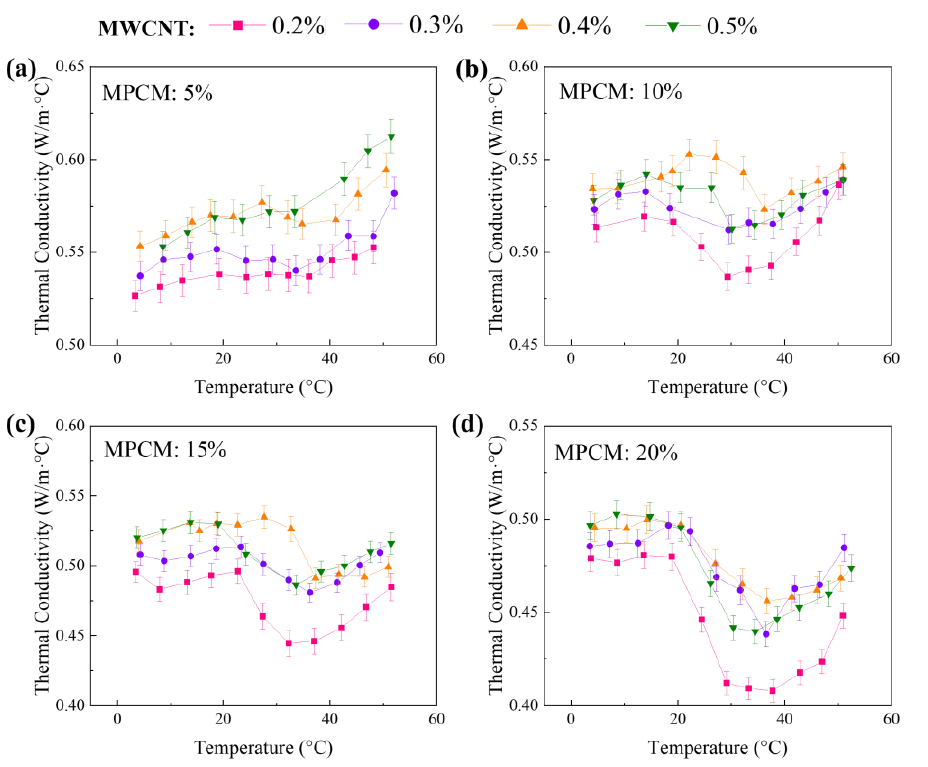
Figure 6. Thermal conductivity of MPCM slurry with different MWCNTs: ( a ) 5%MPCM, ( b ) 10%MPCM, ( c ) 15% MPCM, and ( d ) 20% MPCM slurry.